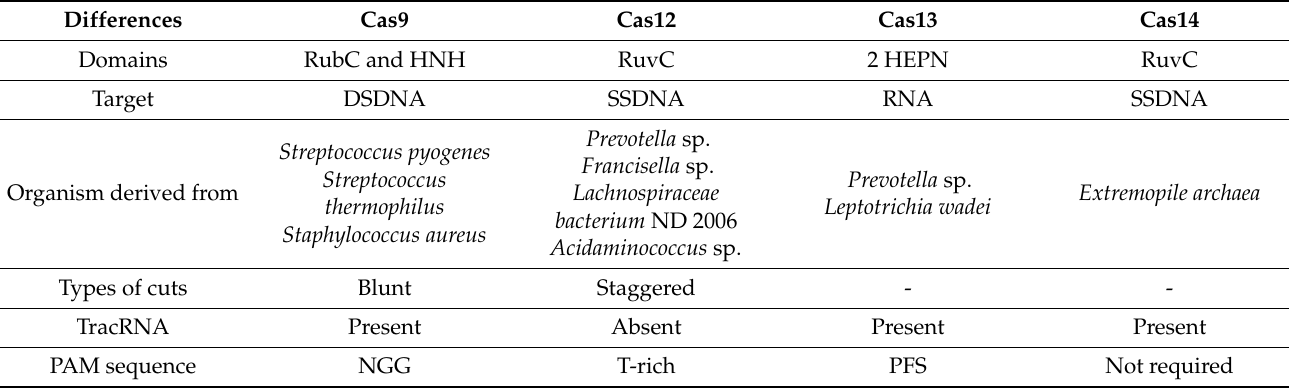
Table 2. The difference between Cas